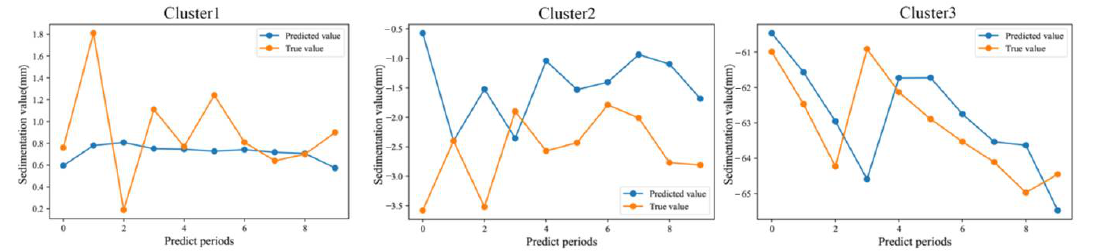
Figure 15. Predicted value and true value of time-series subsidence data under different types of LSTM model.